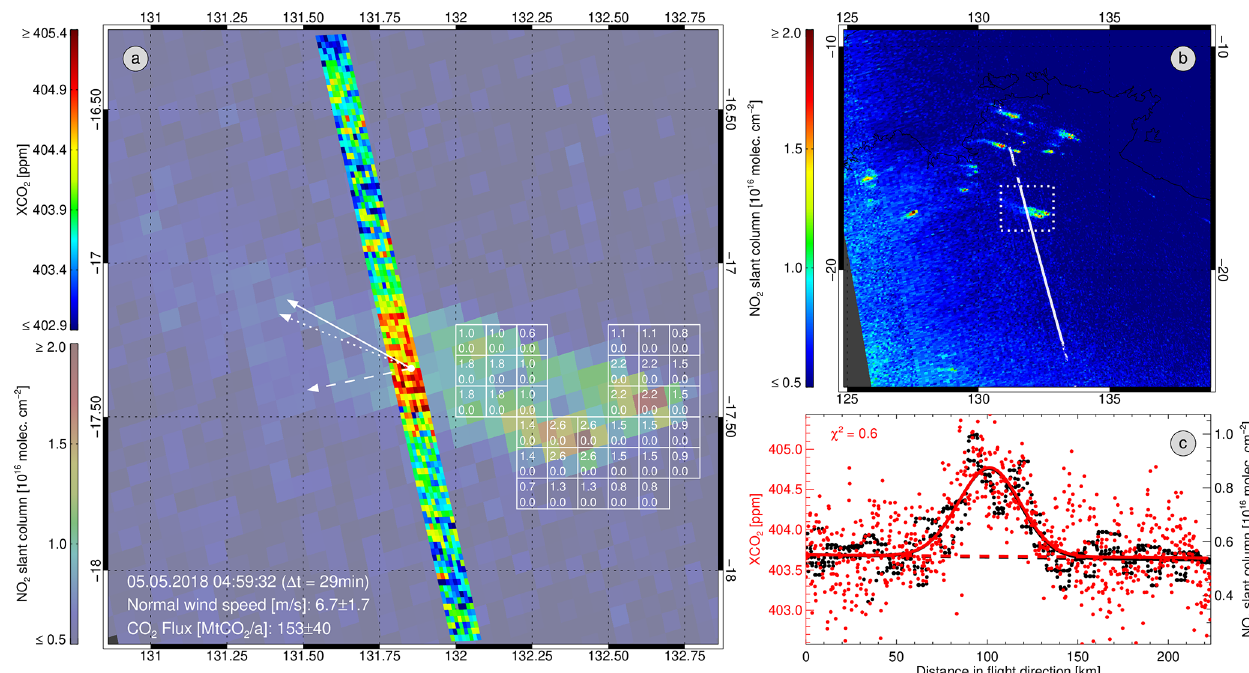
Figure 5. As in Fig. 1 but for the Australian wildfires on 5 May 2018. The ODIAC emission data (the top number in the white boxes) have been replaced by GFED emissions for the time of the OCO-2